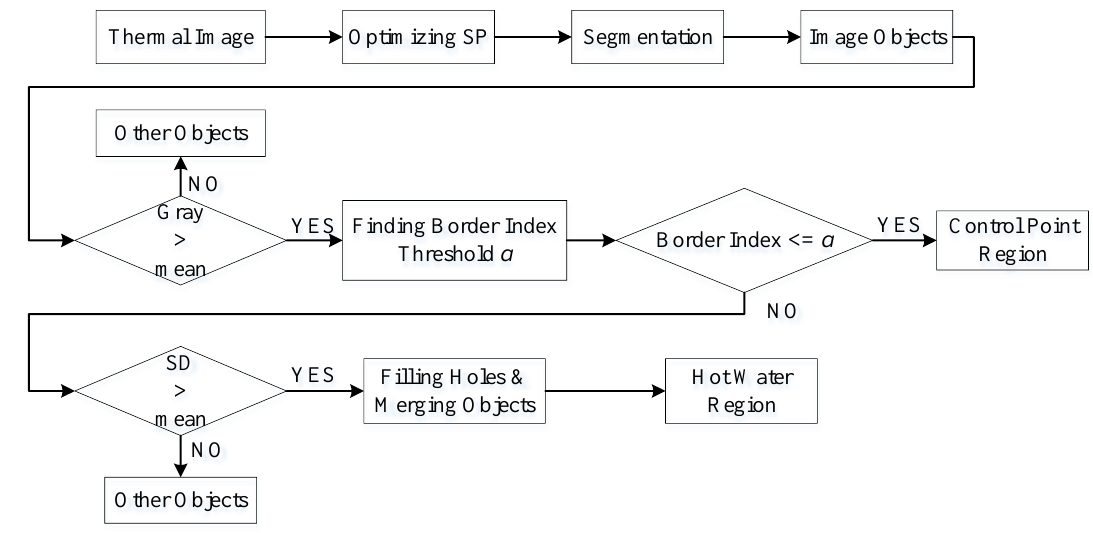
Figure 5. Workflow of Interest Regions